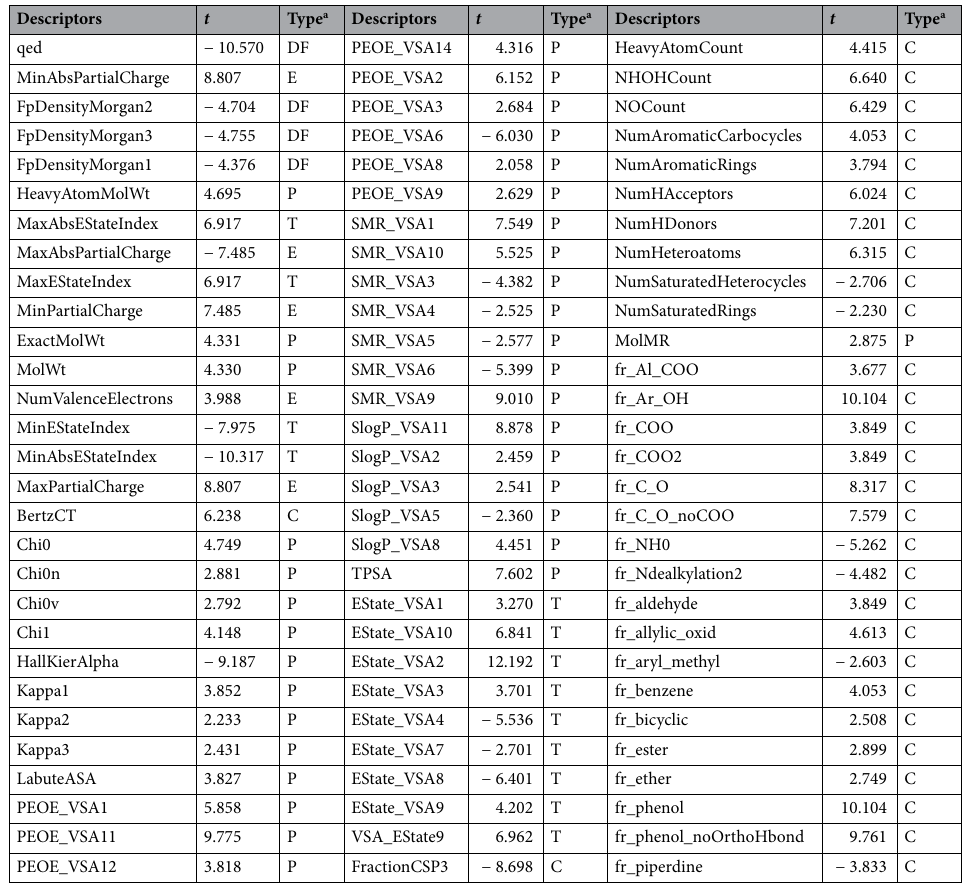
Table 1. Results of filtering molecular descriptors by t -test. All the P values were less than 0.05. a The types of molecular descriptors: “DF” denotes drug-likeness and molecular fingerprints “P” denotes physicochemical property, “T” denotes topological property, “C” denotes constitutional property, “E” denotes electronic